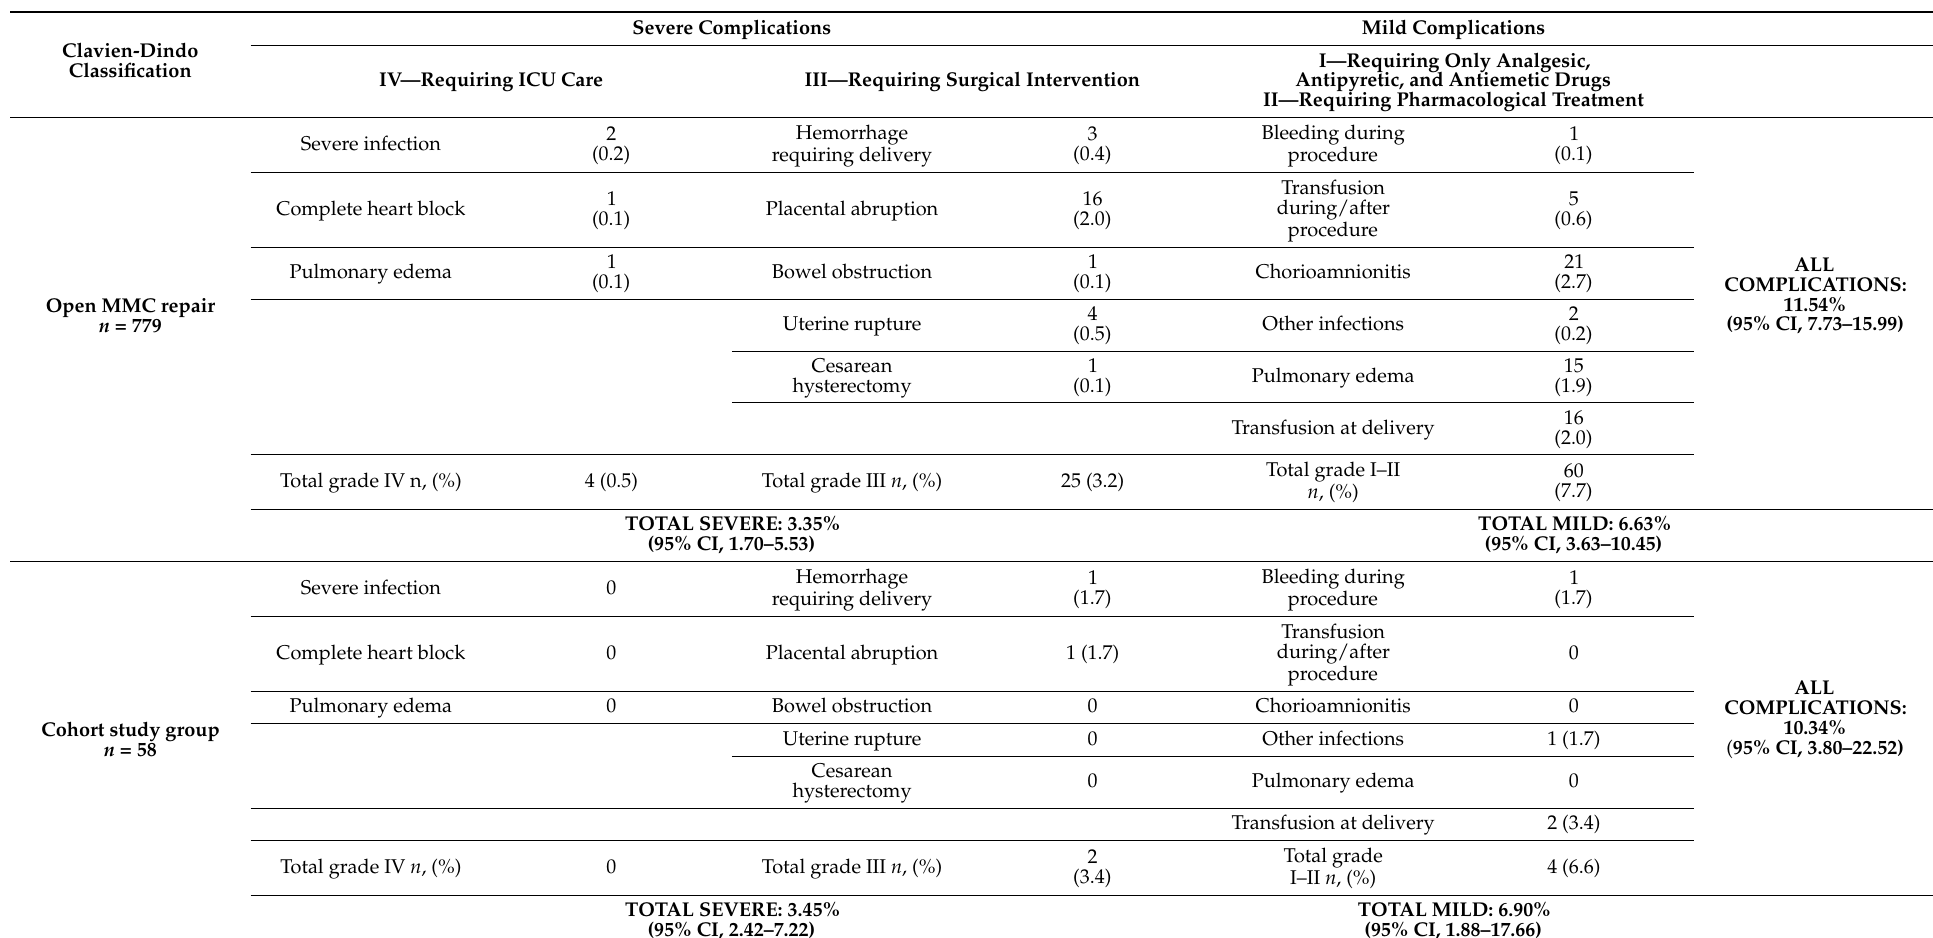
Table 3. Maternal morbidity in the study group compared to the global data of the fetoscopic technique or open surgery of MMC, according to the Clavien- Dindo